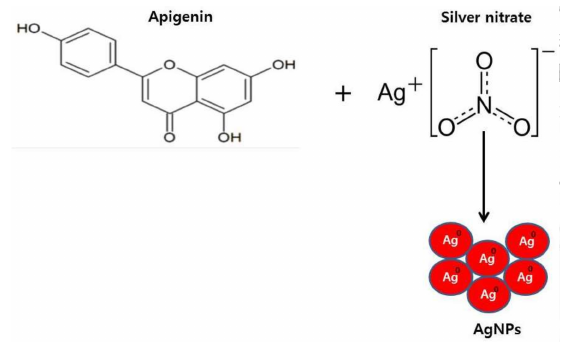
Figure 1. Schematic diagram of a simple and environmentally friendly approach for the synthesis of silver nanoparticles (AgNPs) by the reduction of silver nitrate to elemental silver using apigenin as a reducing